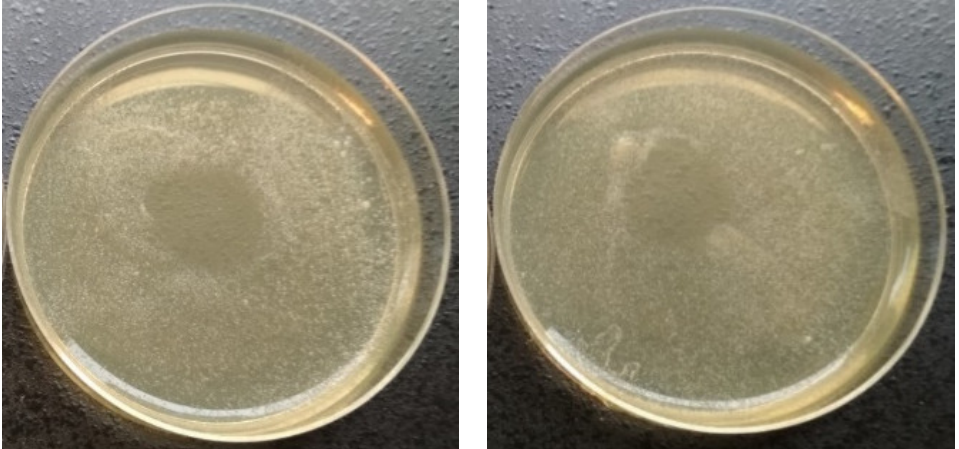
Figure 6. Comparison of exposure times needed for the creation of the same zone size when using 120 s at 9 W ( left ) or 60 s at 12 W ( right ) in the case of the 10-fold dilution after the 24 h cultivation.